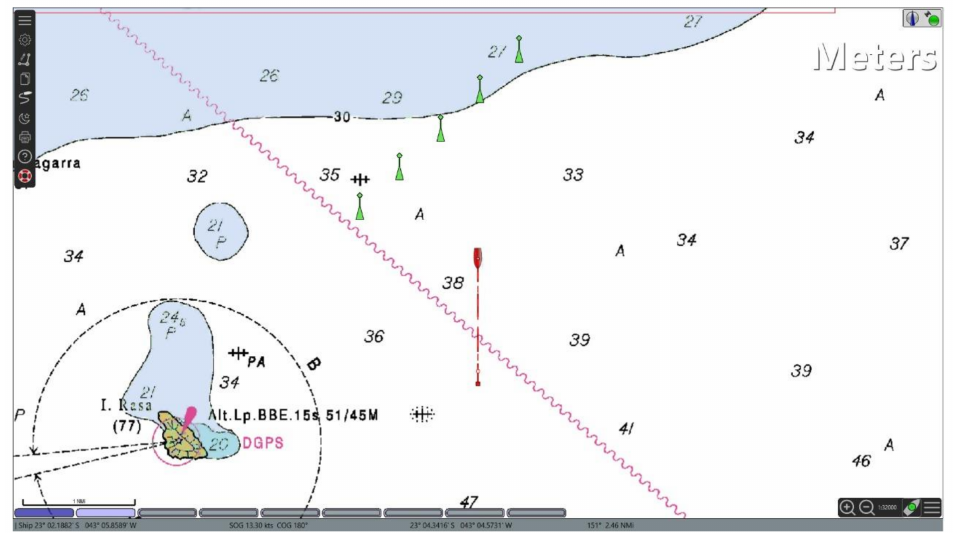
Figure 6. ECDIS screen displaying five false ships (green triangles with projected green lines) whose data was received through forged AIS